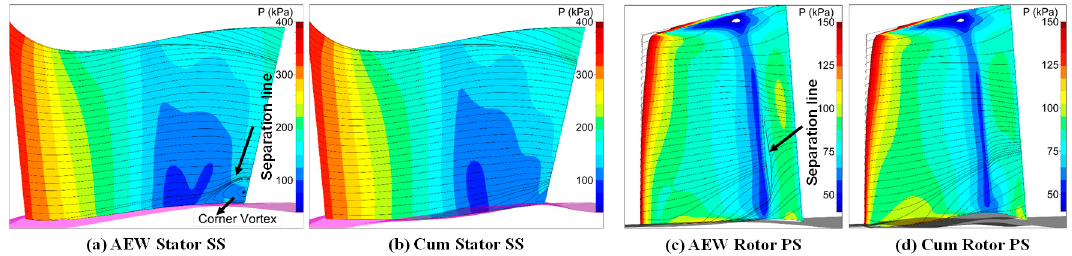
Figure 17. ( a – d ) Static pressure contours superimposed with limiting streamlines.